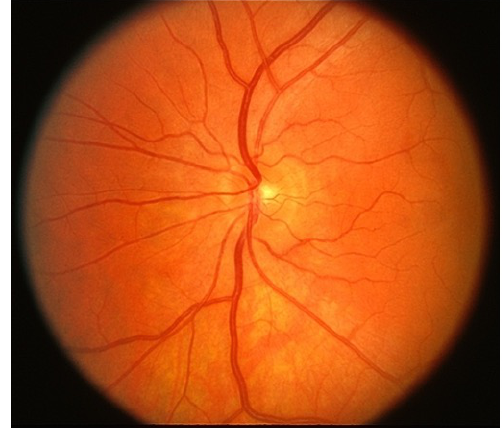
Figure 2. Normal